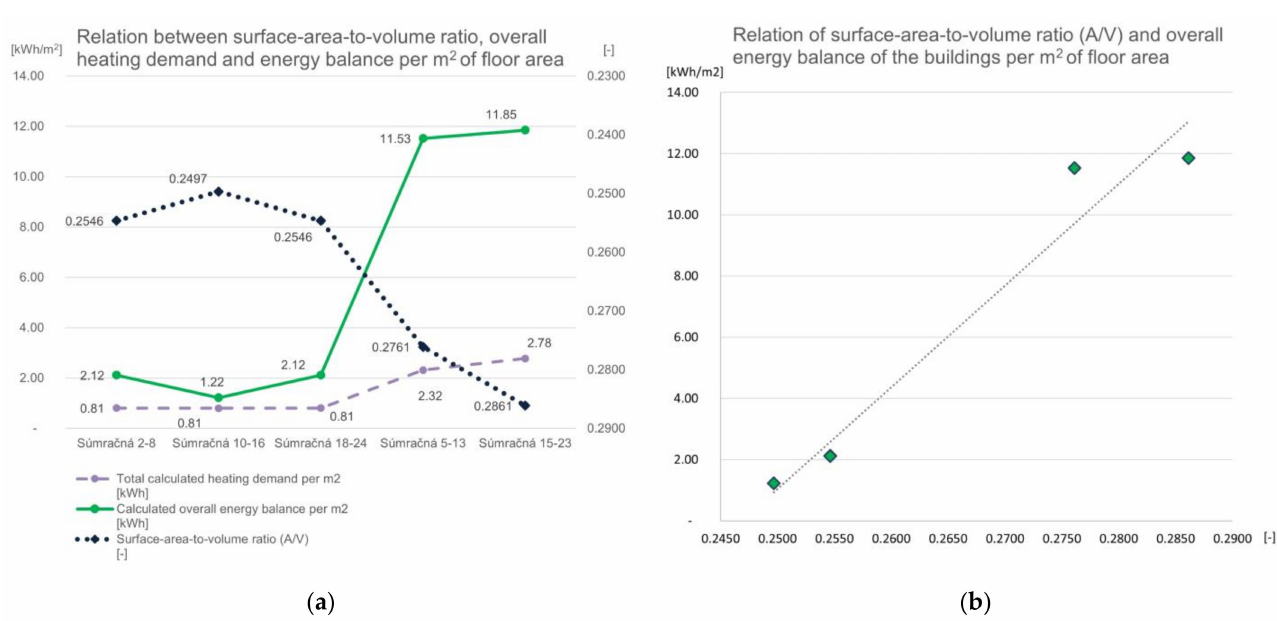
Figure 13. The relationship between surface-area-to-volume ratio (A/V), overall heating demand, and energy balance per m 2 of floor area. ( a ) The chart plotted with values on y-axis shows that, while the calculated heating demand corresponds to the A/V (the lower the A/V value, the lower the heating demand), the overall energy balance (which includes active energy gains) does not; ( b ) Relation of surface-area-to-volume ratio (A/V) and overall energy balance of the buildings per m 2 of floor area plotted on x-axis and y-axis shows that A/V correlates with values of overall energy balance, but inversely—higher (worse) A/V values correspond to better energy